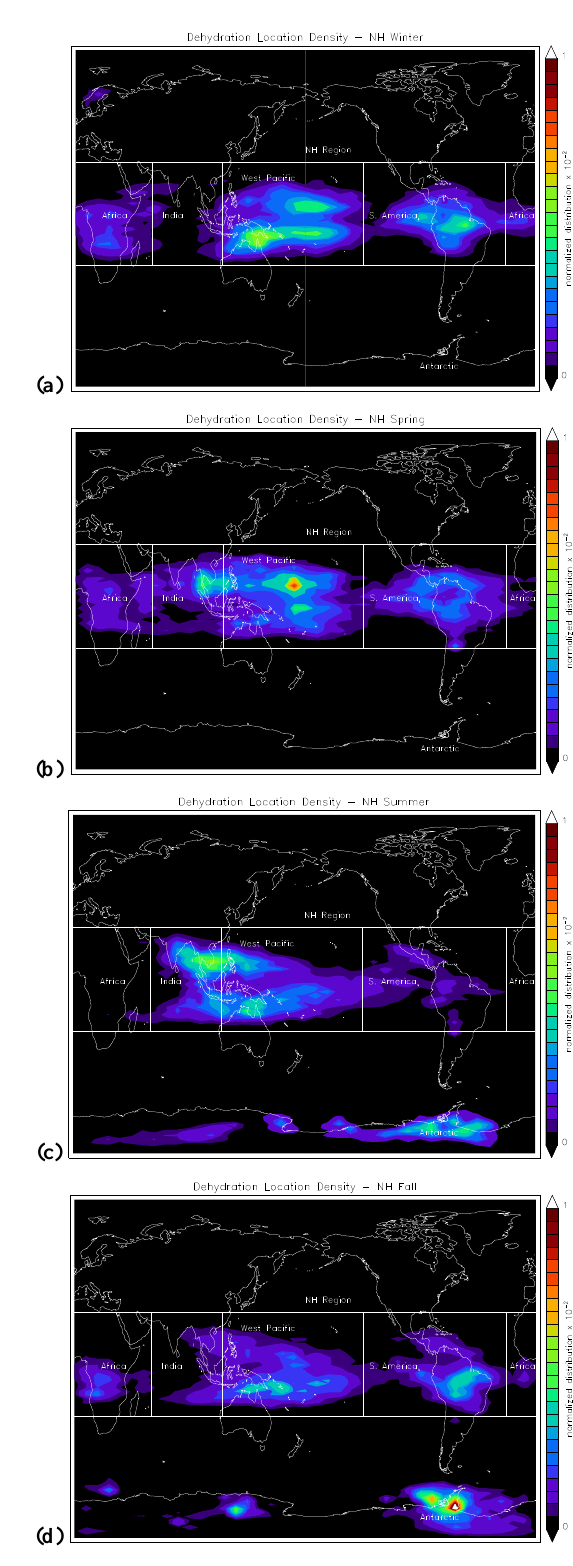
Fig. 9. Density of final dehydration frequency by season. Upper left (a) winter, upper right (b) spring, lower left (c) summer, lower right (d)